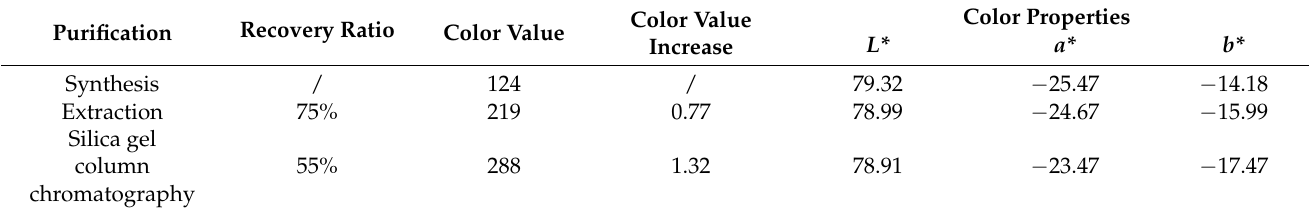
Table 1. The results of purification of the water-insoluble gardenia blue